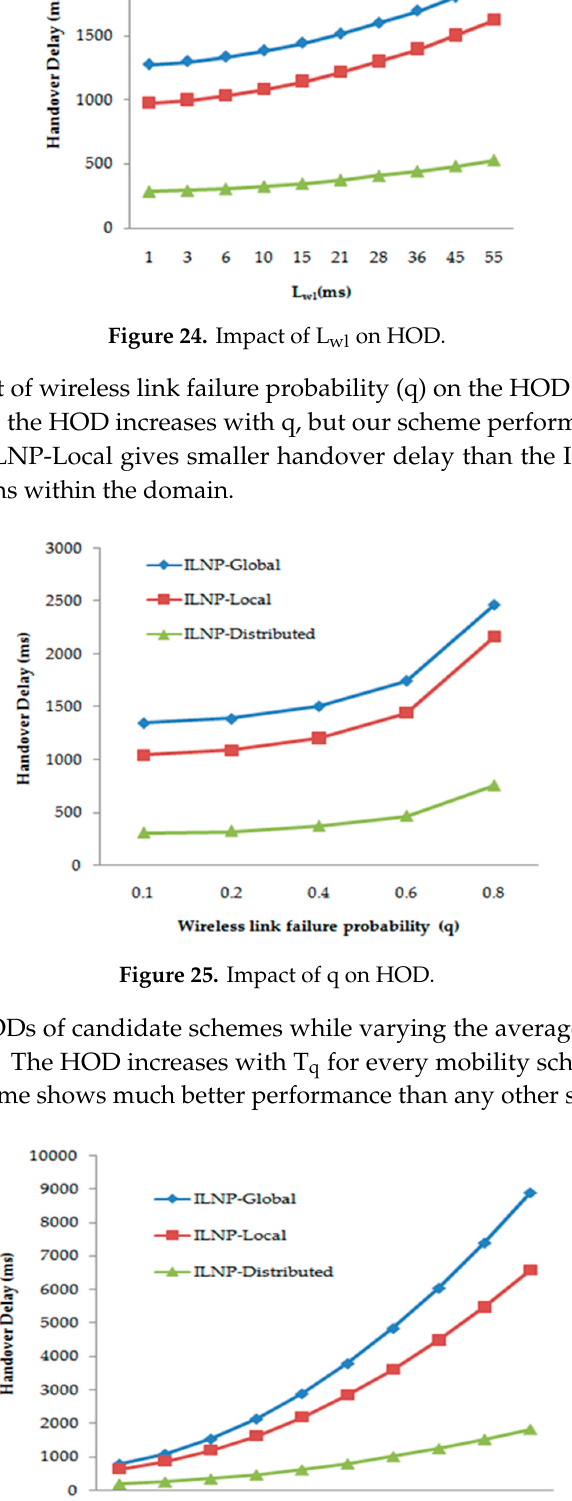
Figure 26. Impact of T q on HOD.